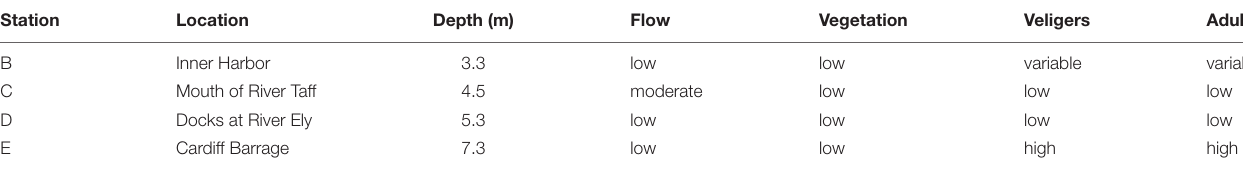
TABLE 2 | Characteristics of the four sampling sites and presence of veligers and adults of zebra mussel reported in a previous study (Alix et al., 2016). Station Location Depth (m)